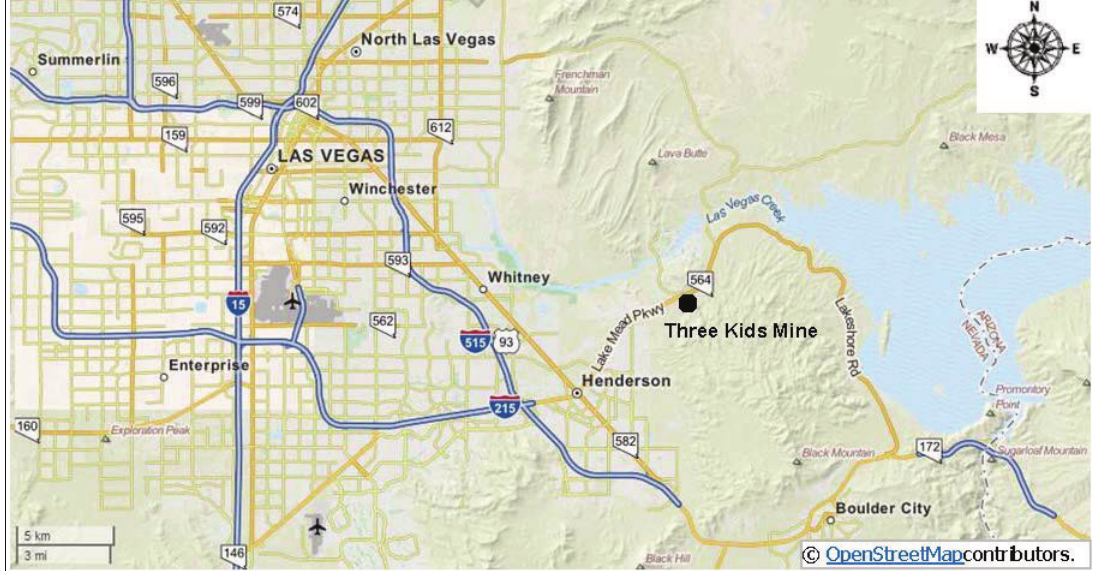
Figure 1. Location of Three Kids Mine in